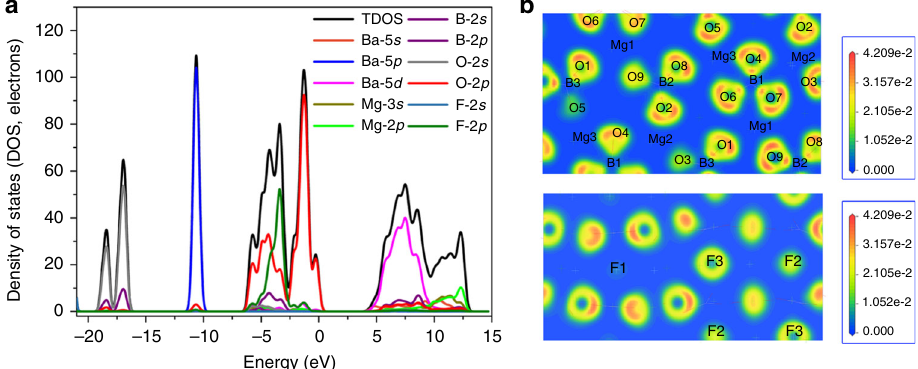
Fig. 7 Theoretical calculation results of Pna 2 1 -Ba 3 Mg 3 (BO 3 ) 3 F 3 . a Partial and total density of states with the energy region from − 22 to 15 eV. b The electron localization function diagrams slice along the bc plane (top of b ) with the slice position of (5.70841, 7.67893, 4.35171) and ab plane (bottom of b ) with the slice position of (4.02830, 7.63500, 7.43644), respectively. Isovalue increases from blue to red, and the maximum electron localization function value is scaled to 4.209 × 10 − 2 for the two electron localization function